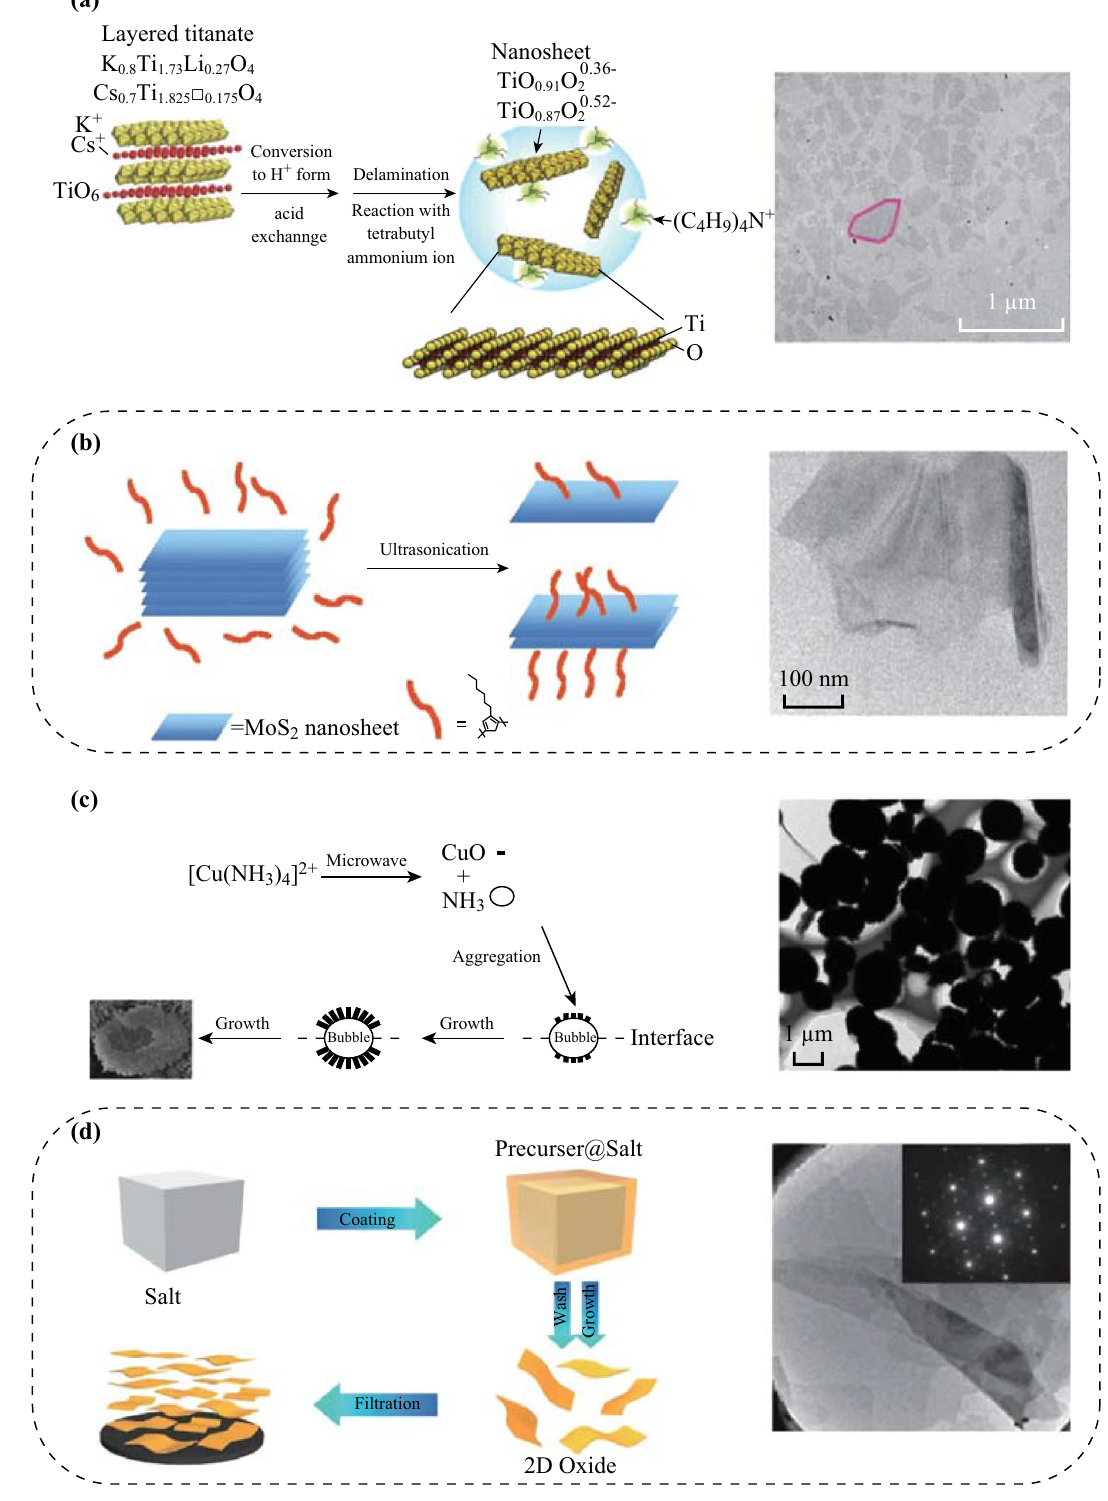
Fig. 4 Schematics of synthesis procedures of a chemical intercalation, b sonication assisted, c microwave assisted d template assisted for producing 2D TMO&C-based photocatalysts and the corresponding transmission electron microscopic images. Reproduced with permission from Ref. [77, 99, 212,